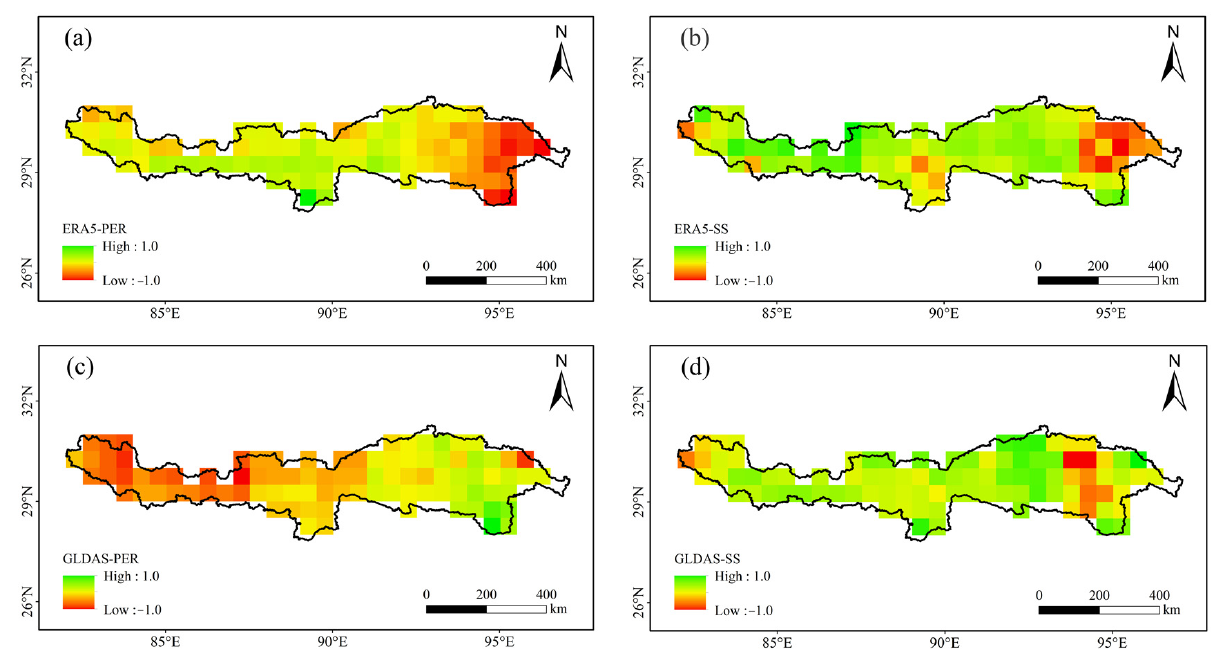
Figure 4. Spatial distribution of the correlation coefficients between TWSC based on ERA5 and GLDAS and results derived from GRACE. ERA5-PER ( a ) represents the correlation coefficients between TWSC estimated by the PER method based on ERA5 and results from GRACE; ERA5-SS ( b ) represents the correlation coefficients between TWSC estimated by the SS method based on ERA5 and results from GRACE; GLDAS-PER ( c ) represents the correlation coefficients between TWSC estimated by the PER method based on GLDAS and results from GRACE; GLDAS-SS ( d ) represents the correlation coefficients between TWSC estimated by the SS method based on GLDAS and results from GRACE. The unit is “1”.